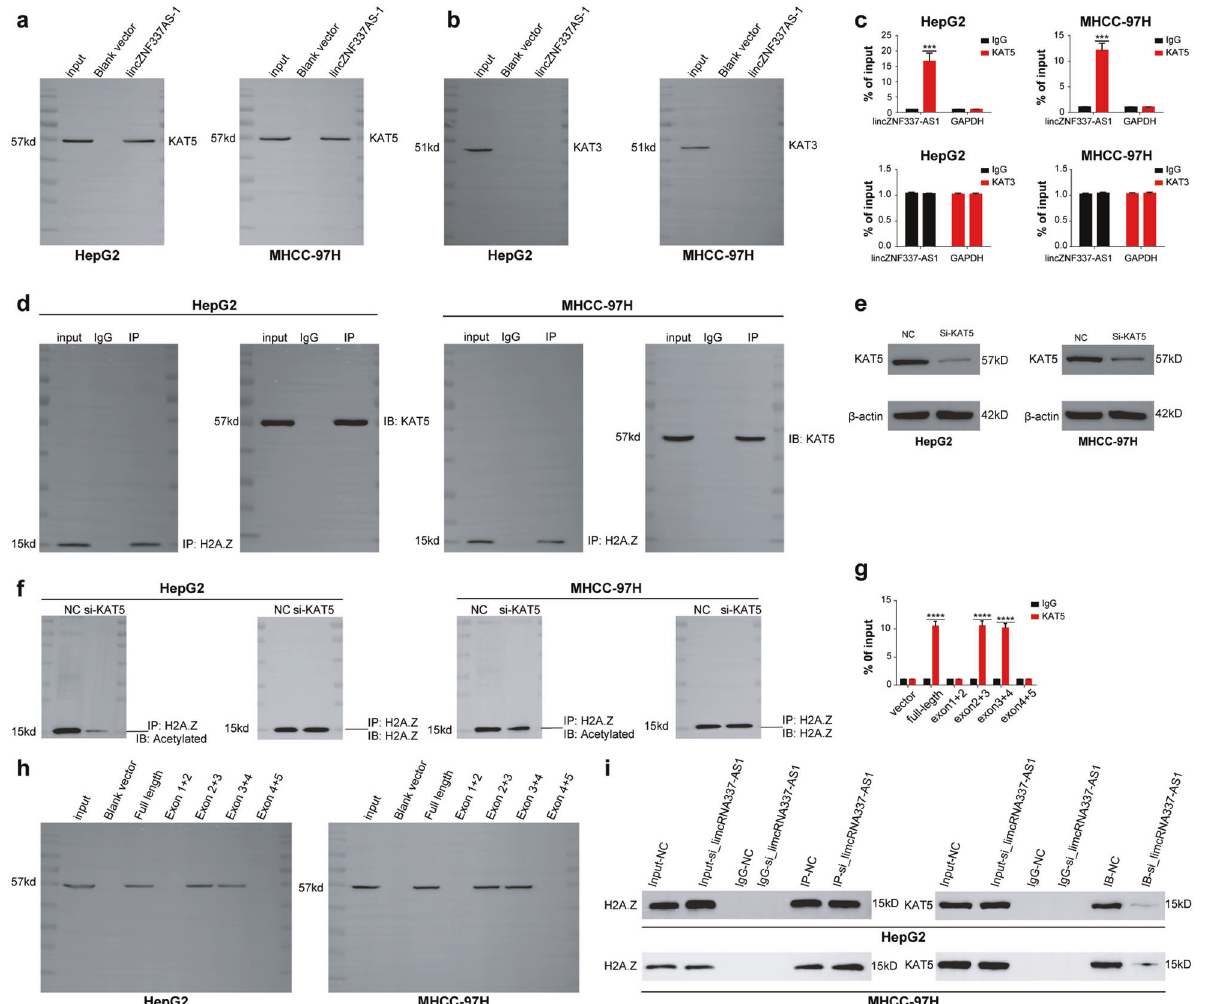
Fig. 7 LincZNF337-AS1 promotes acetylation of H2A.Z through KAT5. a – b RNA-pulldown assay veri fi es lincZNF337-AS1 binding to KAT5, not KAT3. c RIP-qPCR assay veri fi es lincZNF337-AS1 binding to KAT5, not KAT3. d Co-IP assay identi fi es the interaction between H2A.Z and KAT5 in HCC cell lines. e Identi fi cation of KAT5 gene knockdown effect by western blot. f , i The effect of knockdown KAT5 and lincZNF337-AS1 on H2A.Z acetylation detected by Co-IP assay. h RNA-pulldown assay veri fi es the binding site of lincZNF337-AS1 to KAT5 in HepG2 and MHCC- 97H cell lines. The data are expressed in terms of mean ± SD (Student ’ s t -test used in Fig c and g ; **** P < 0.0001; n = 3 in each